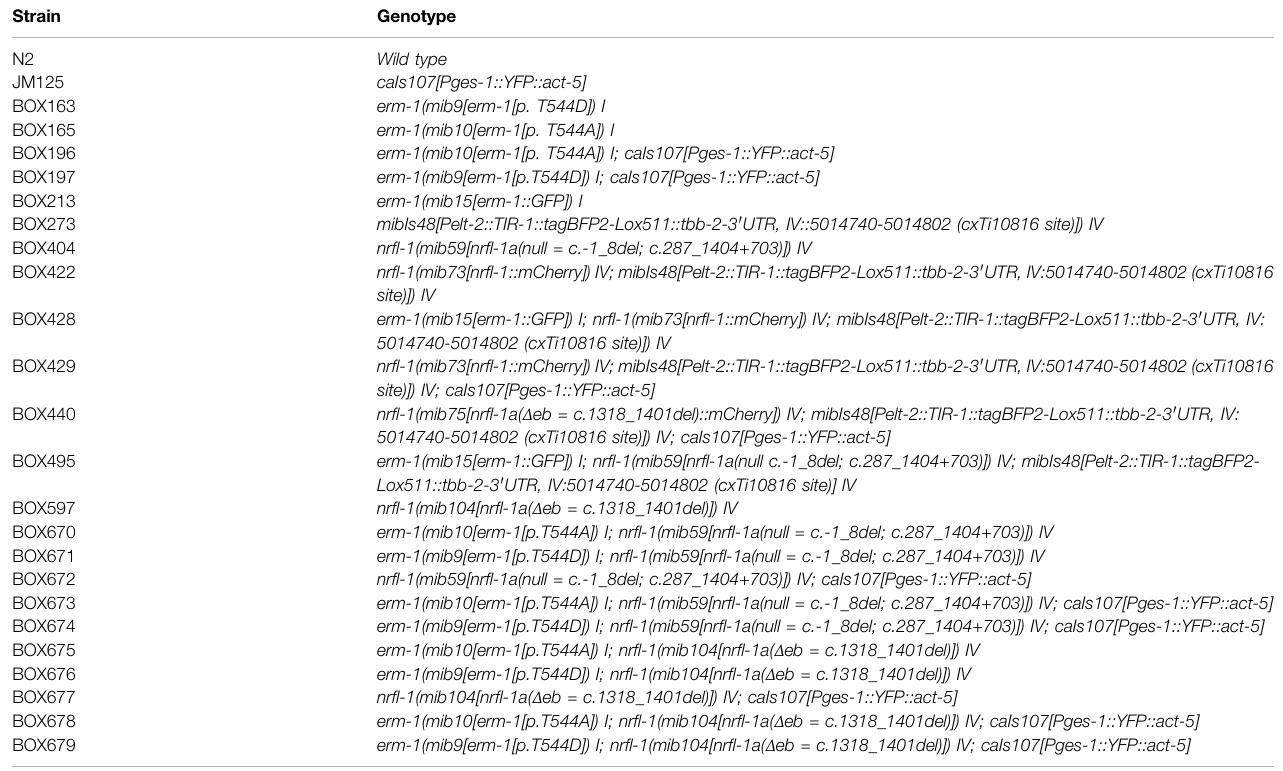
TABLE 1 | List of C. elegans strains used Strain